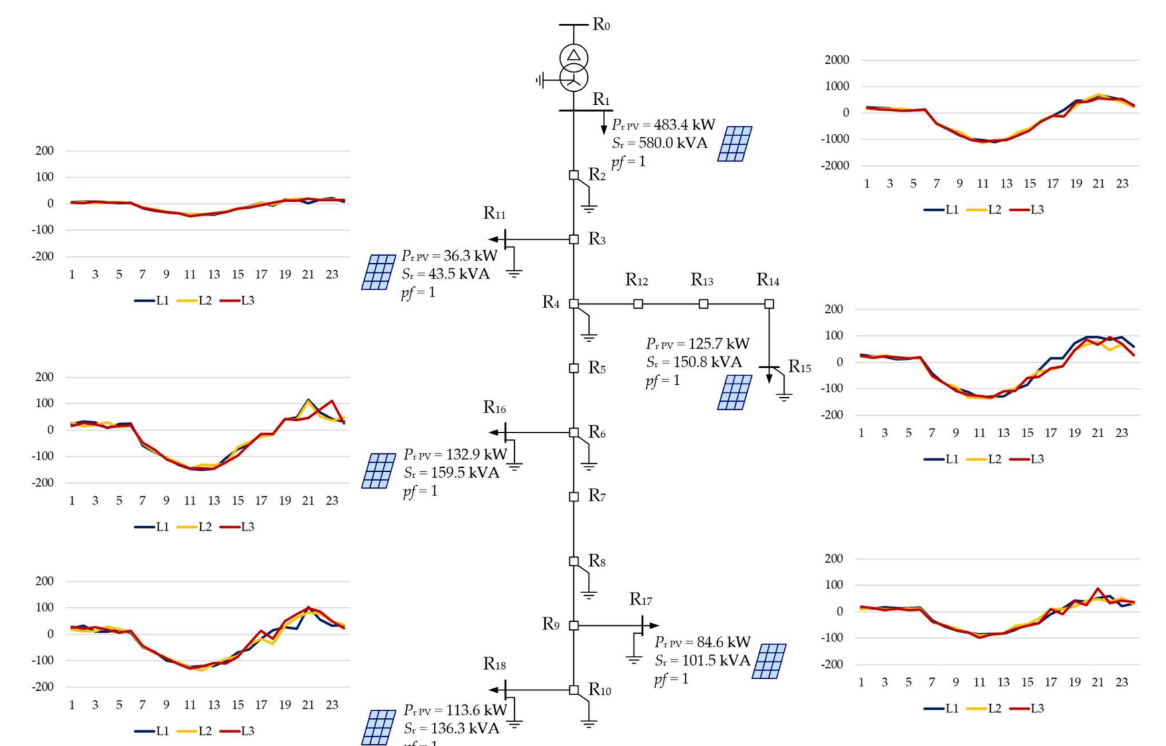
Figure A10. Daily simulation results for variant V8: phase currents